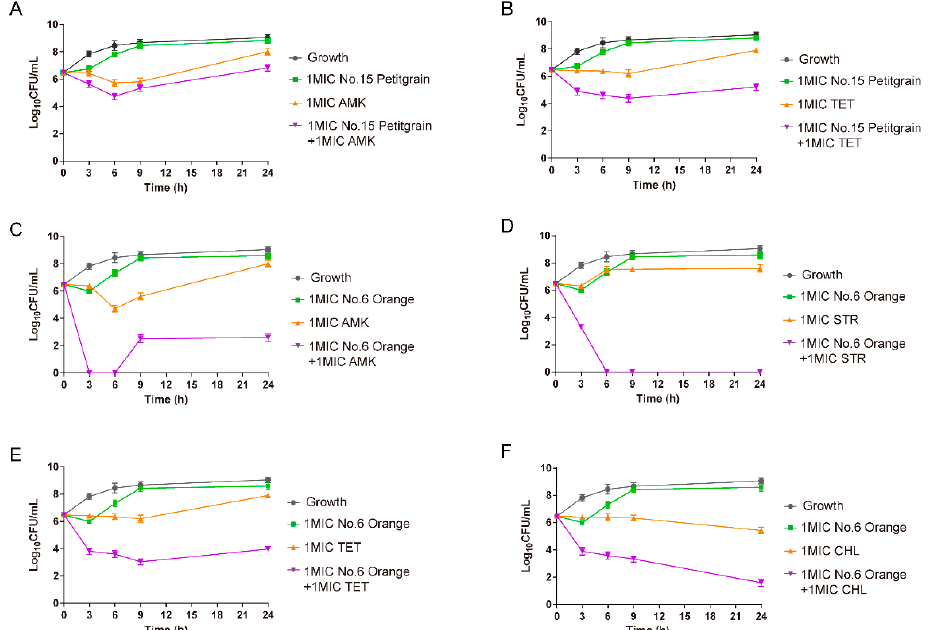
Figure 2. Time-kill curves showing effects of Petitgrain (15) with ( A ) amikacin ( B ) tetracycline and orange (6) with ( C ) amikacin, ( D ) streptomycin, ( E ) tetracycline, and ( F ) chloramphenicol both at 1× MIC against E. coli ATCC 25922.